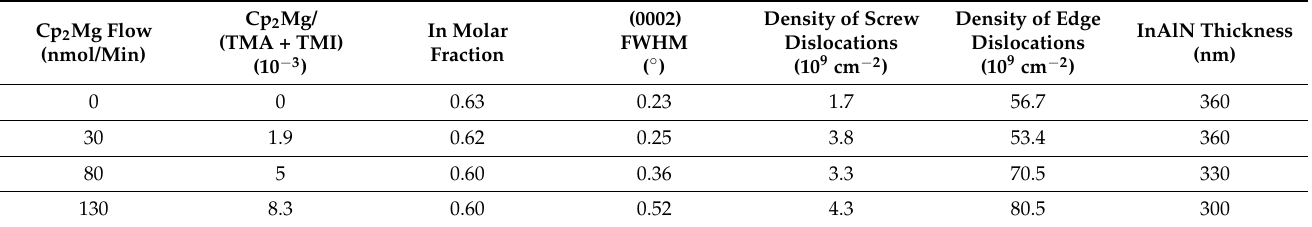
Figure 1. XRD 2 Θ / ω scan of InAlN (0002) XRD diffractions for different Cp 2 Mg flow. Table 1. InAlN layers material parameters for different Cp 2 Mg flow. FWHM refers to 2 Θ / ω scan shown in Figure 1.